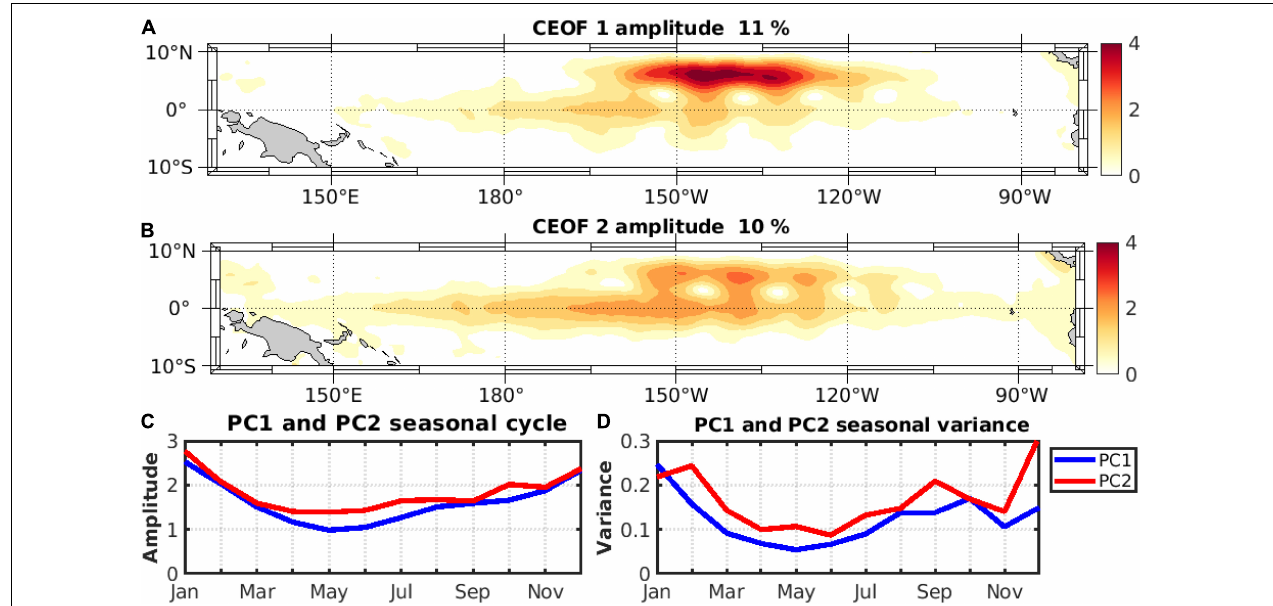
FIGURE 1 | Decomposition into Complex Empirical Orthogonal functions (CEOF) of intraseasonal sea level anomalies (over the period 1993–2018). Spatial patterns of the amplitude of the first CEOF1 (A) and second CEOF2 (B) mode. (C) Seasonal cycle of each mode’s corresponding Principal Component (PC) amplitude, (D) seasonal cycle of each PC amplitude’s monthly variance (PC1 in blue and PC2 in